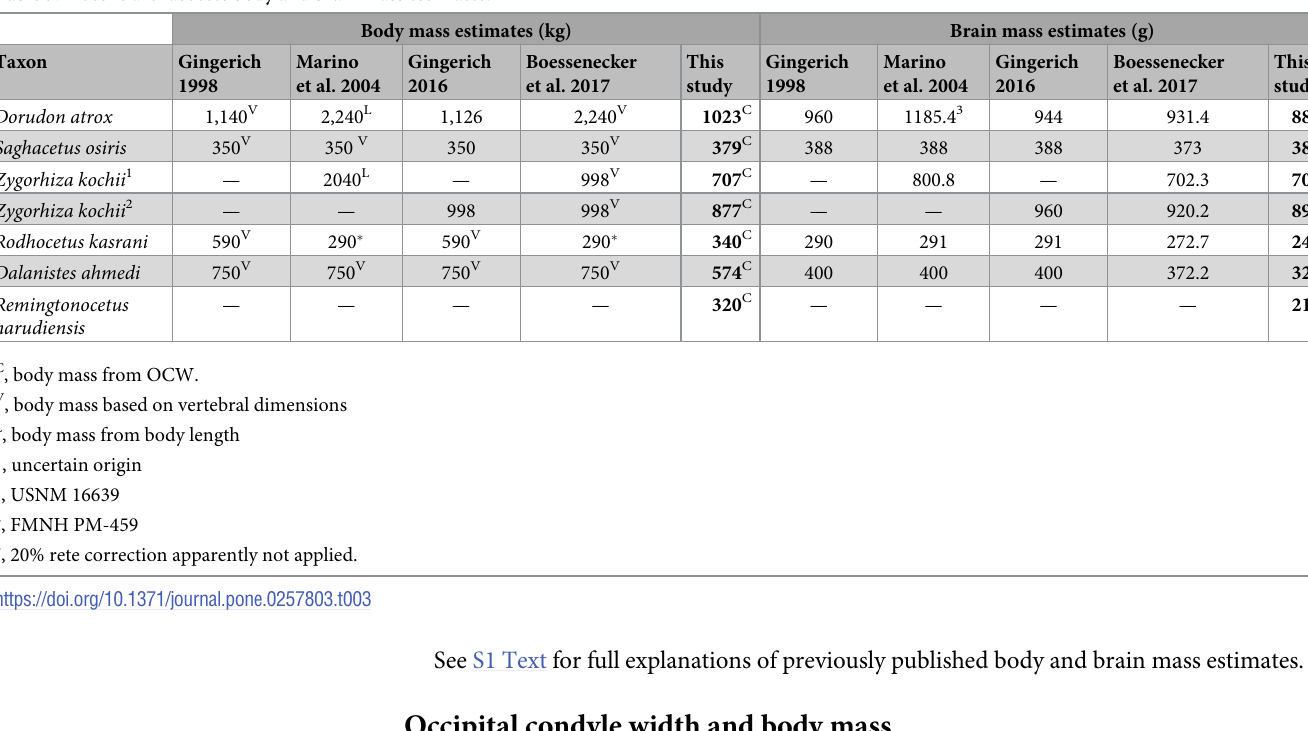
Table 3. Eocene archaeocete body and brain mass